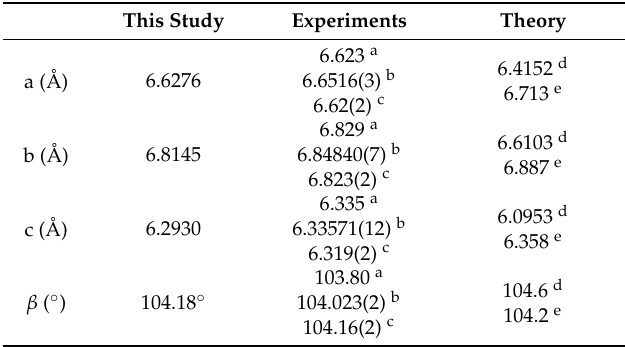
Table 1. Structural parameters of monazite-type GdPO 4 at 0 GPa.